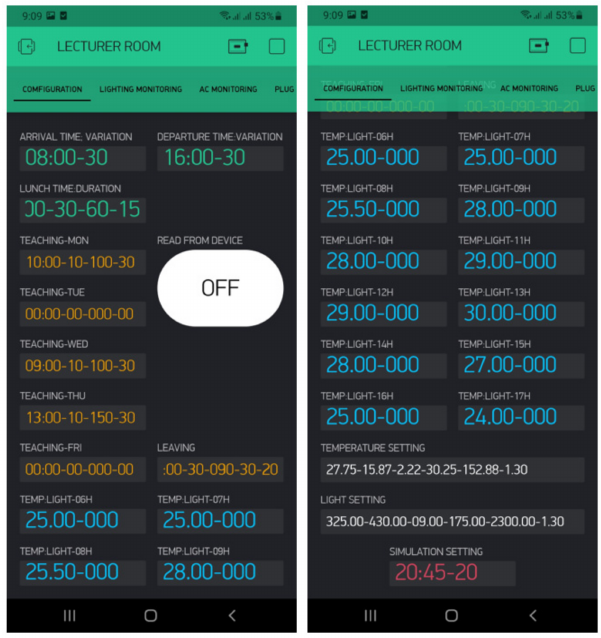
Figure 7. Blynk application for configuring the